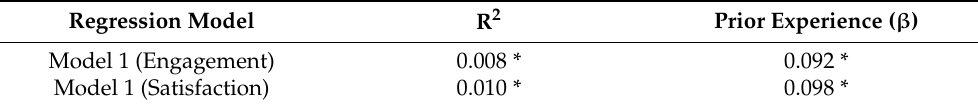
Table 3. Regression Results: Prior Experience Predicting Engagement and Satisfaction. Regression Model R 2 Prior Experience ( β ) Model 1 (Engagement) 0.008 * 0.092 * Model 1 (Satisfaction) 0.010 * 0.098 * * p < 0.05.